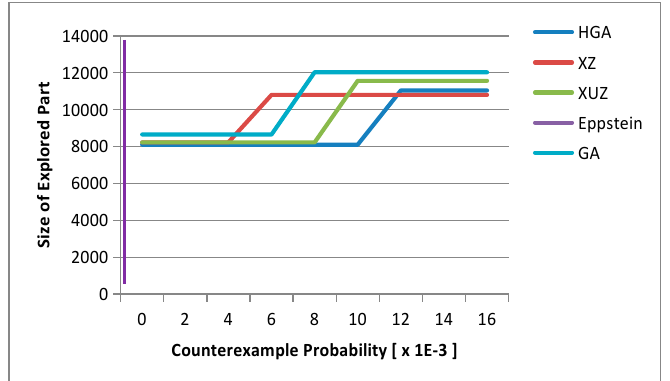
Figure 7. Counterexample probability of leader election.